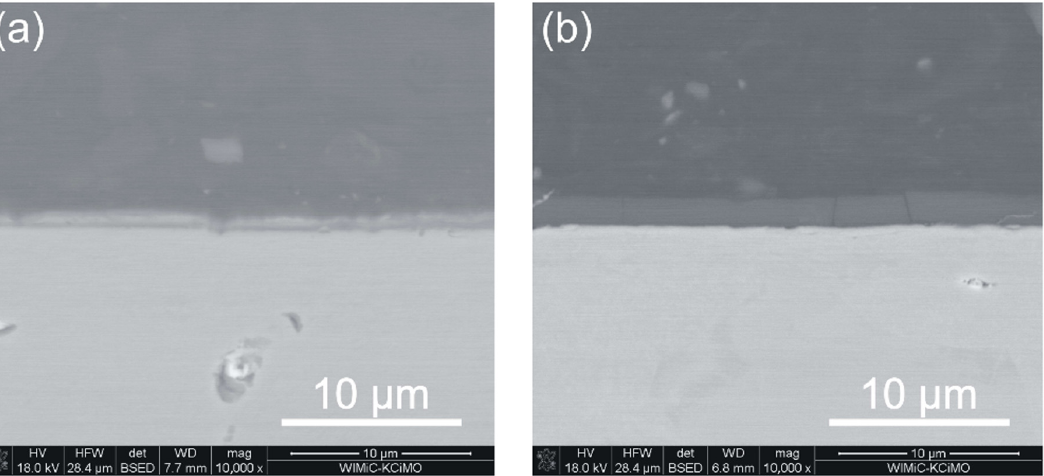
Figure 2. SEM images of the Crofer 22 APU steel samples cross-sections: ( a ) with SiC x N y :H layer, ( b ) with SiC x N y :H layer preceded by the nitriding